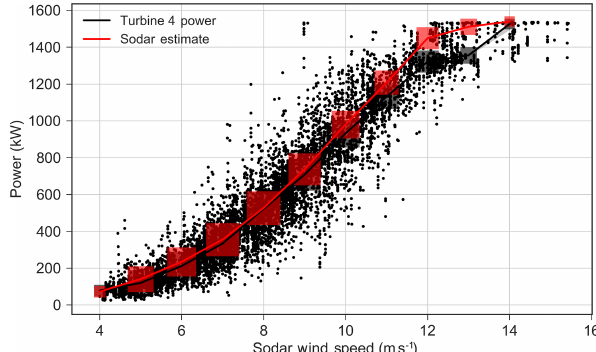
Figure 10. Sodar available power fit. The data from T4 are shown in black and the sodar estimate is shown in red. The red boxes refer to the wind speed bins and the size refers to the amount of data in each